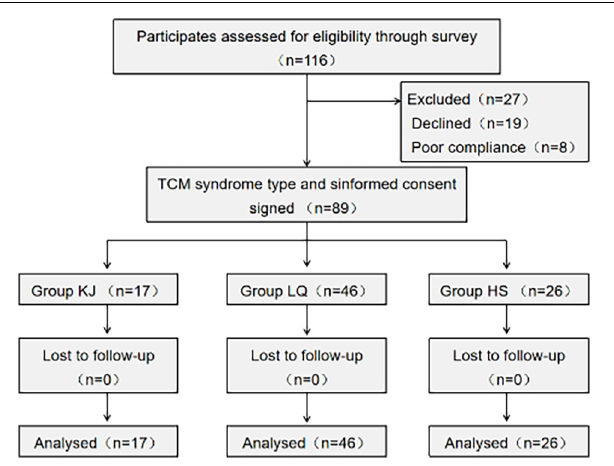
FIGURE 1 | Flow diagram of the subject: screening, grouping, and intervention. KJ group, kidney jing deficiency group ( n = 17); LQ group, Liver Qi stagnation group ( n = 46); HS group, group with deficiency of both the heart and spleen ( n =